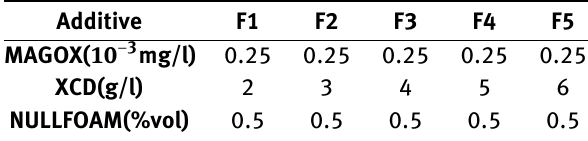
Table 1: Fluid formulations